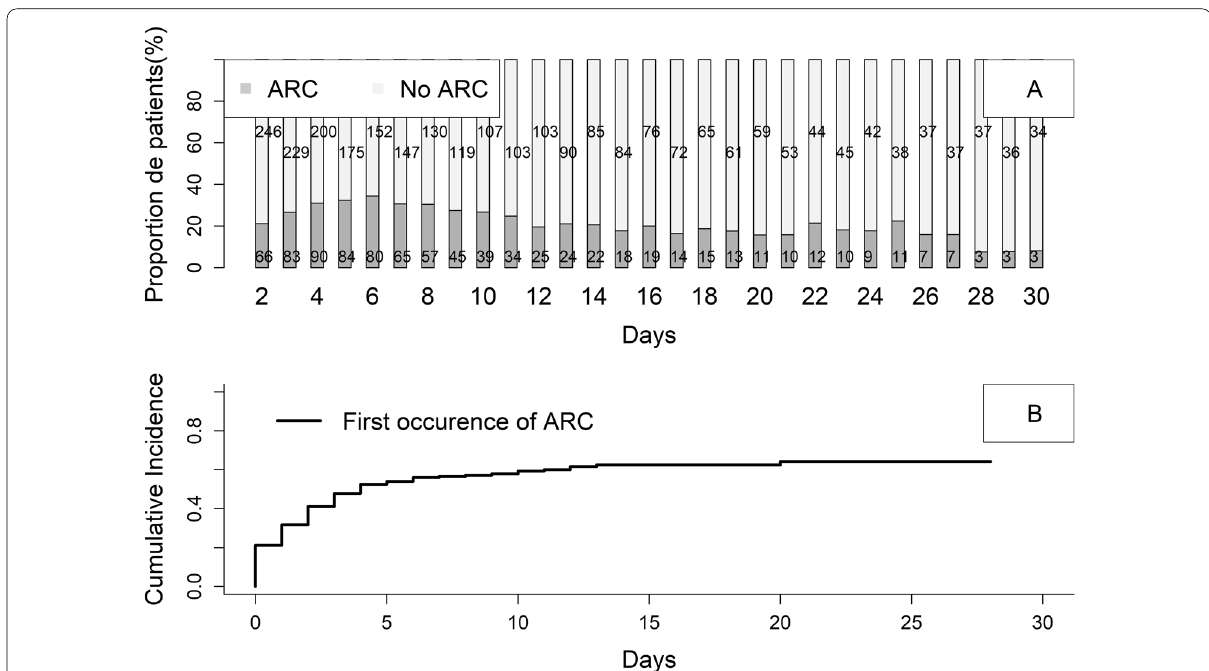
Fig. 1 Daily prevalence ( A ) and cumulative incidence ( B ) of augmented renal clearance in ICU from day 1 to day